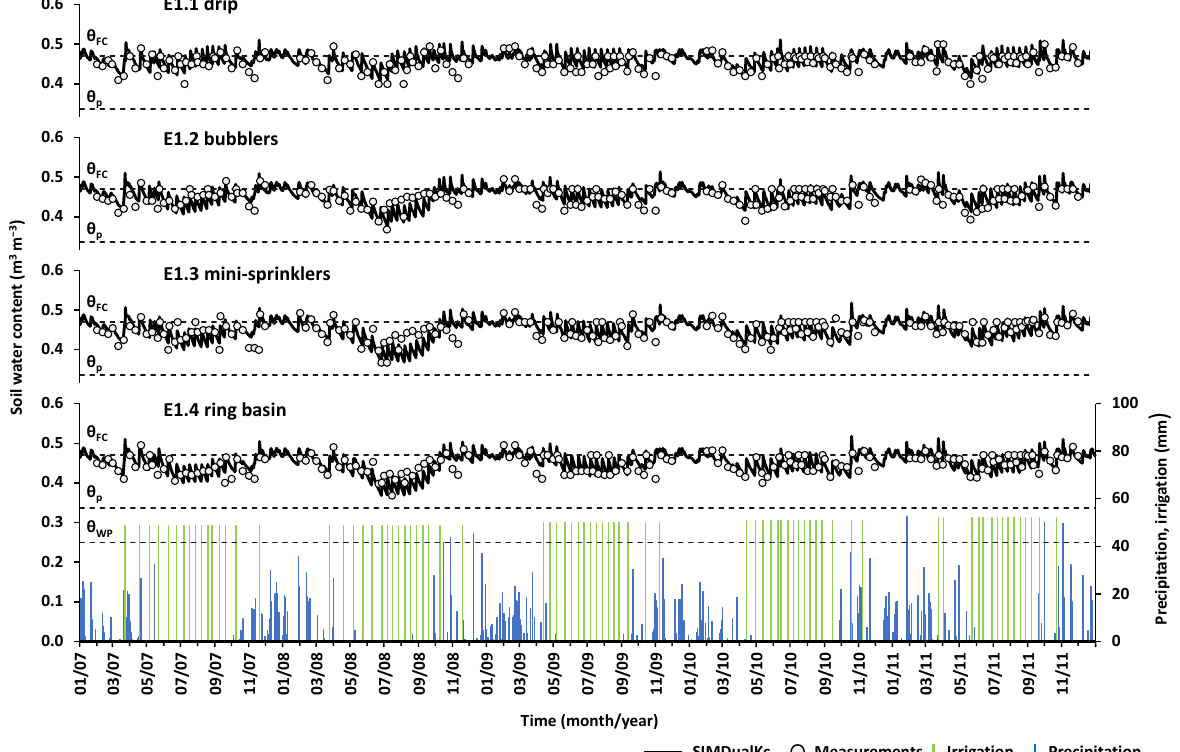
Figure 4. Measured and simulated soil water contents in the E1.1 drip, E1.2 bubbler, E1.3 micro- sprinkling, and E1.4 ring-basin treatments during the 2007–2011 growing seasons ( θ FC , θ WP , and θ p refer to soil water contents at field capacity, wilting point, and depletion fraction for no stress, re- spectively).